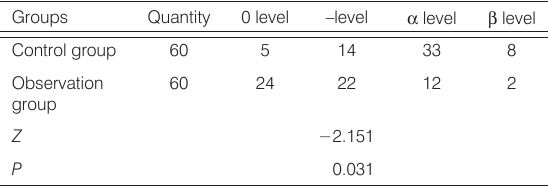
Table 2. Comparison of the frequency and degree of nausea after the